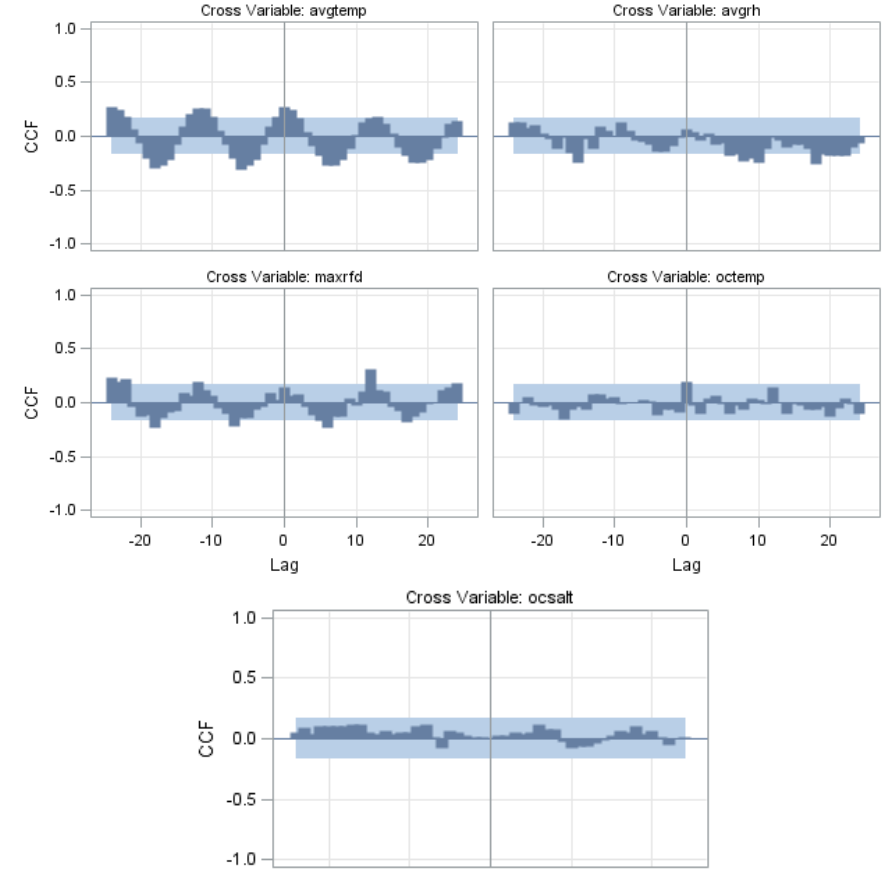
Figure 4. The cross ‐ correlation coefficients of V. parahaemolyticus outbreaks with climatic variables: avgtemp, avgrh, maxrfd, octemp, and ocsant in Taiwan, 2000–2011. Gray area represents the two standard error limits.